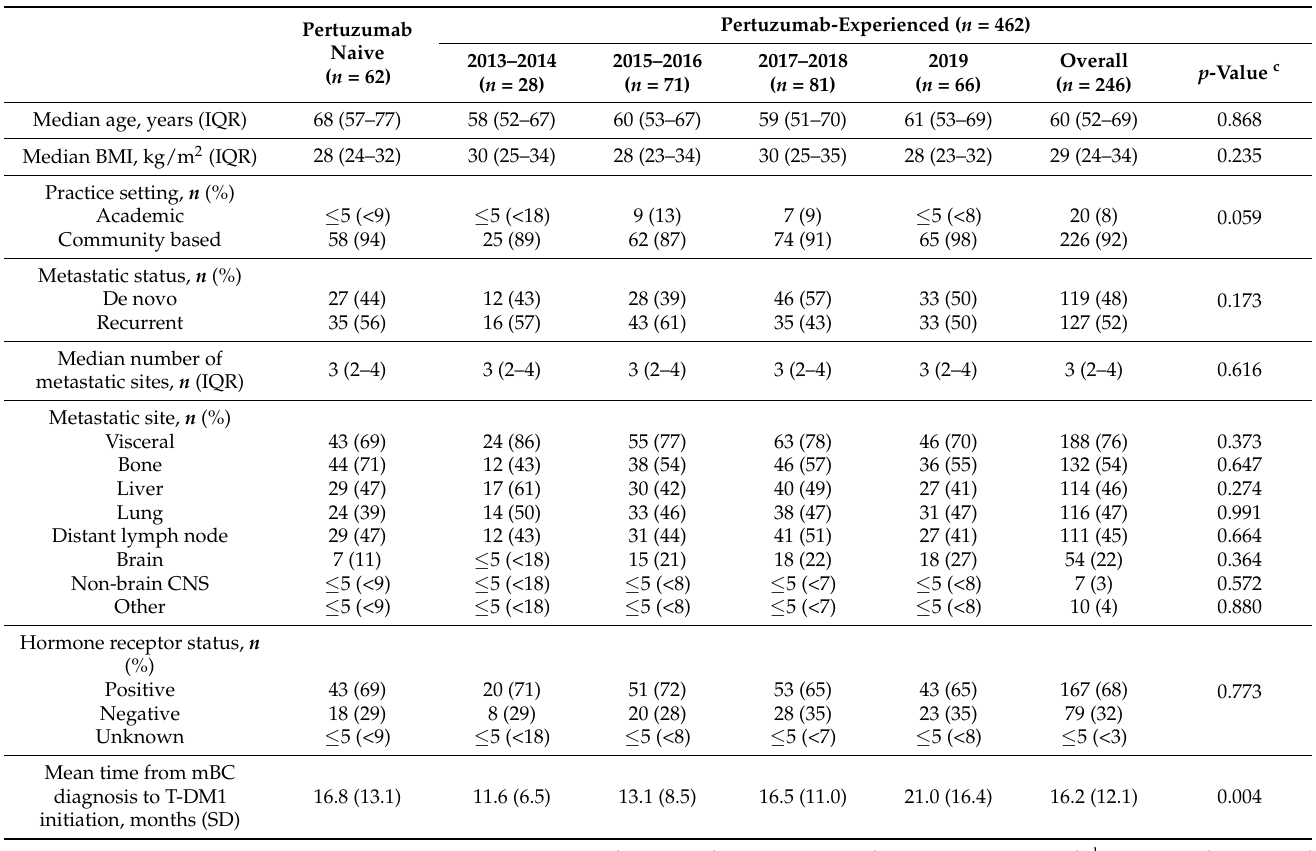
Table A2. Demographic and disease characteristics on the index date a in the secondary cohort b .